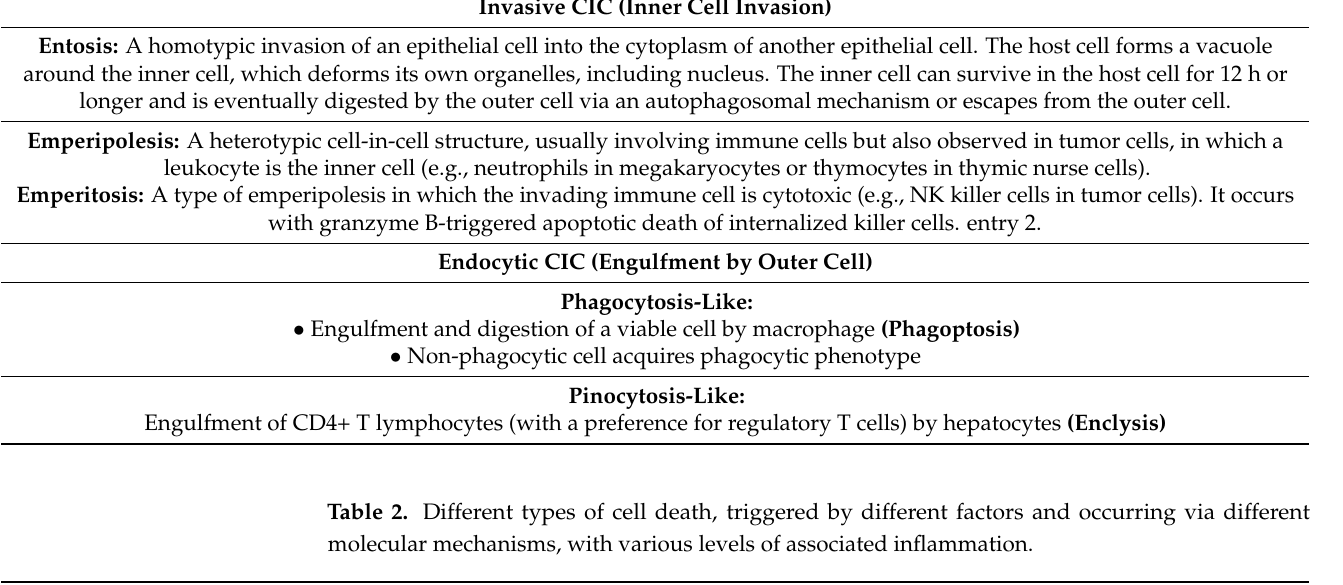
Table 1. Different types of cell-in-cell structures. Inner cell invasion can proceed homotypically, with epithelial cells of the same type (entosis), or heterotypically, when the invading cell is of a different type (usually leukocyte). The other type of CIC is formed when the outer cell actively engulfs the inner cell, in a process resembling endocytosis.